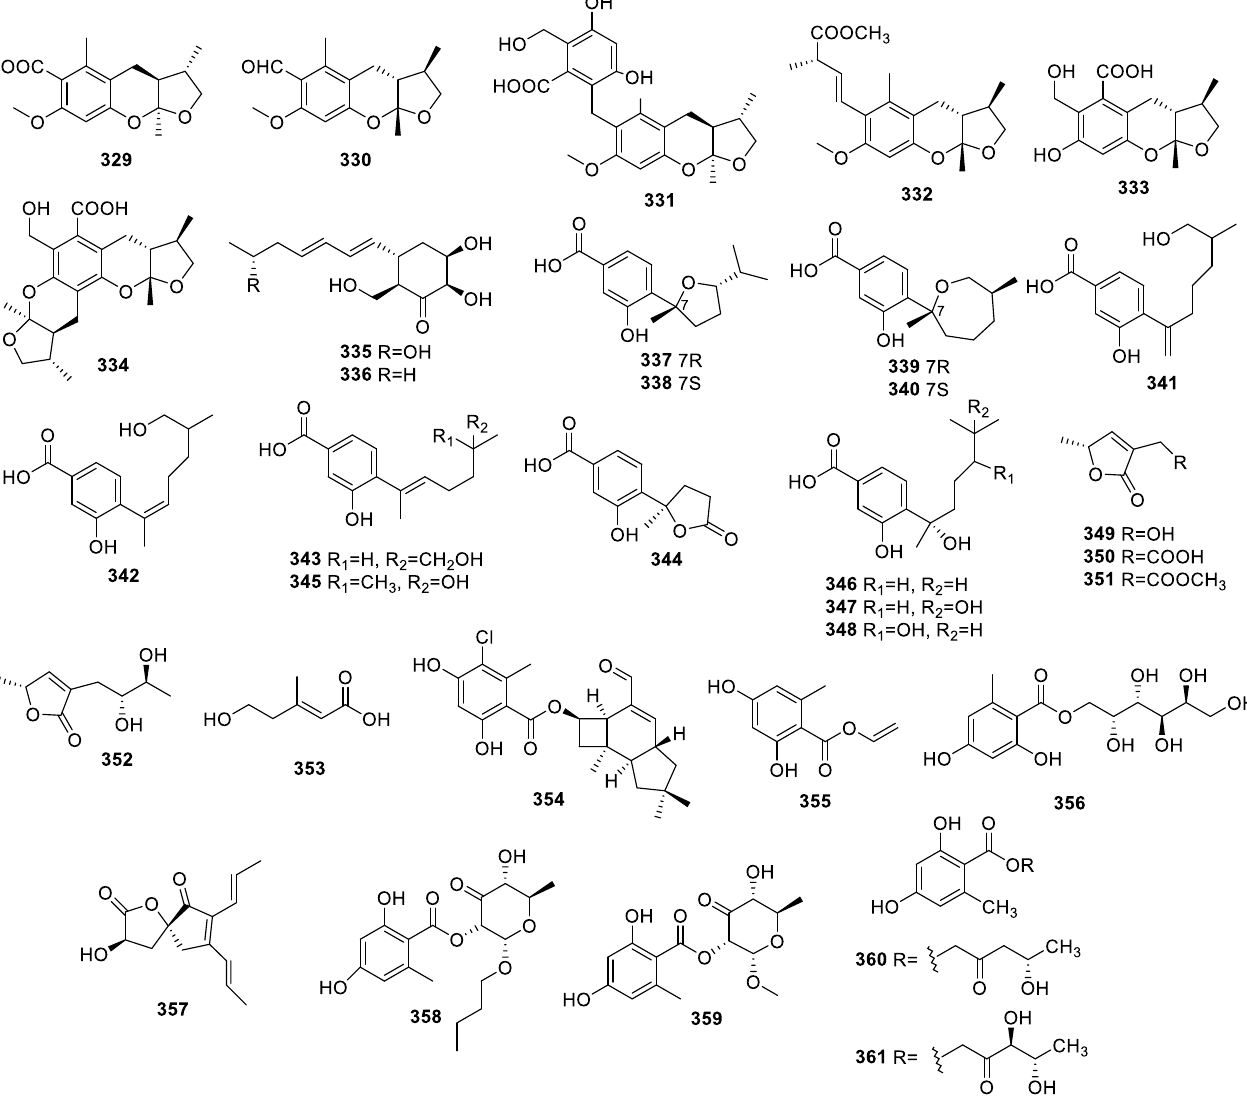
Figure 14. Chemical structures of other polyketides ( 329 – 361 ).